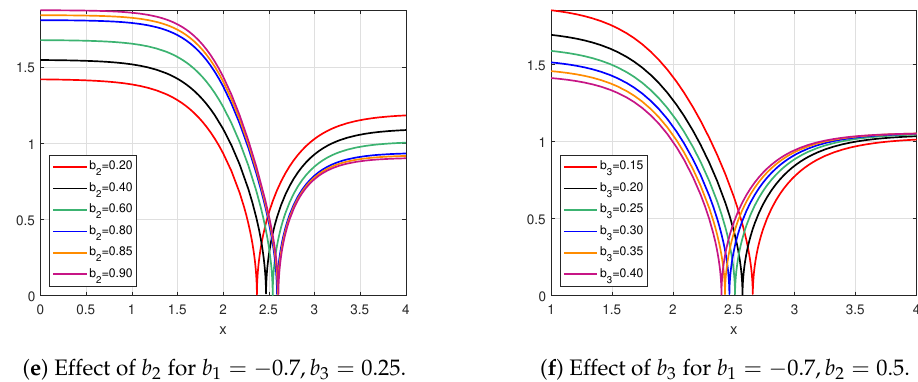
Figure 2. The various views of u 5 ( x , t ) in Equation (23) by combination of the Set 2 in Equation (13) and the selected h = − 0.04, a = − 0.5, φ 0 = 0.5, b 1 = − 0.7, b 2 = 0.5, b 3 = 0.25, κ = 2 values.